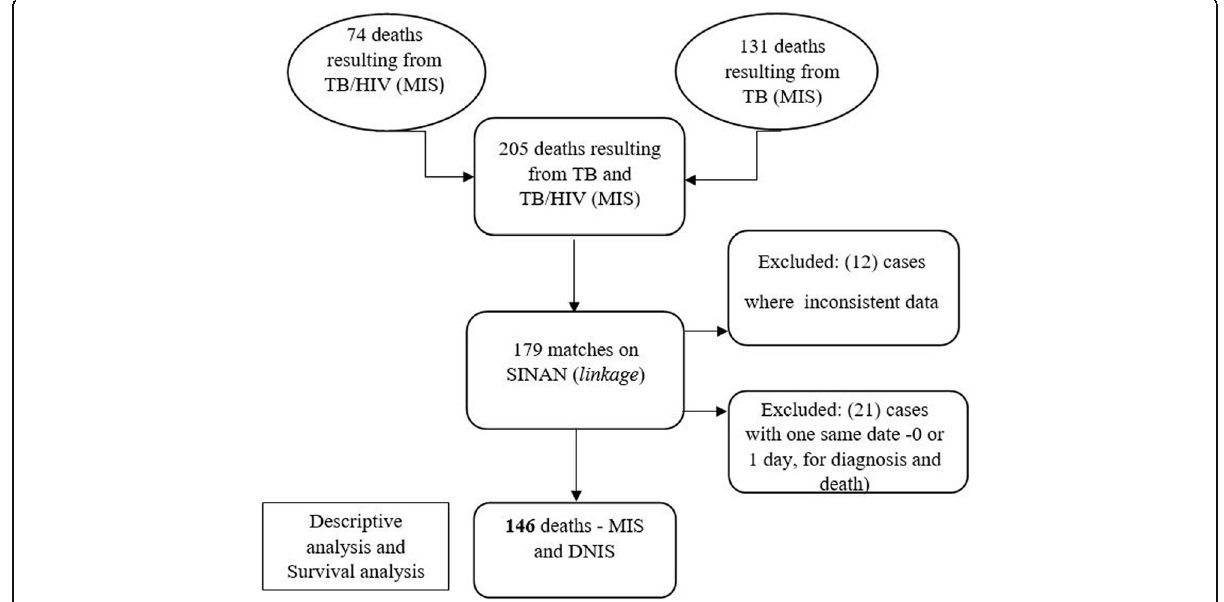
Fig. 1 Flow chart of deaths analyzed in the